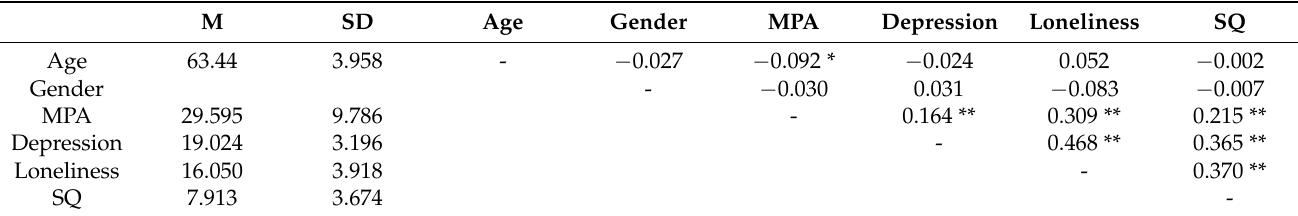
Table 1. Descriptive statistics and correlation coefficients for the variables.